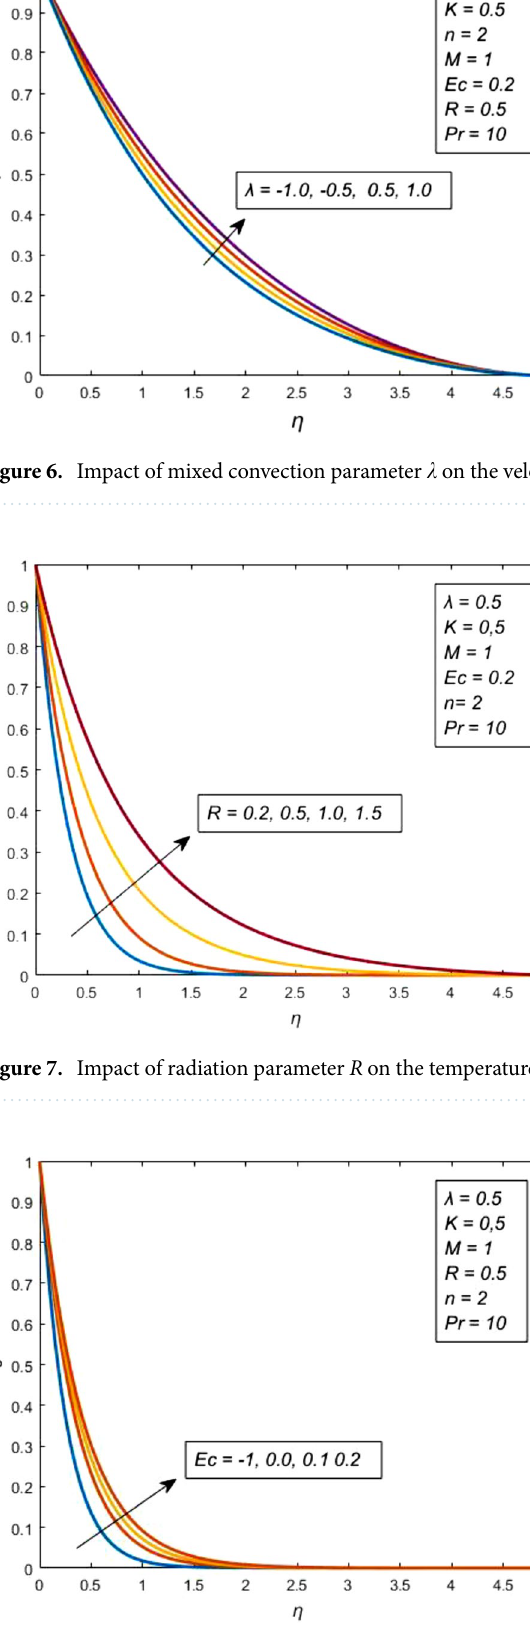
Figure 8. Impact of Eckert number Ec on the temperature